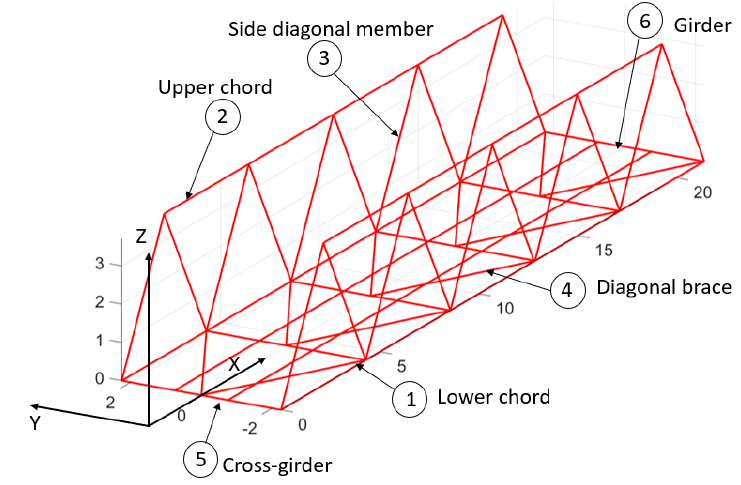
Figure 1. The scheme of the open Warren truss bridge considered in the paper. Table 1. Span dimensions, natural frequencies and geometrical properties of each element shown in Figure 1. Section Area Element